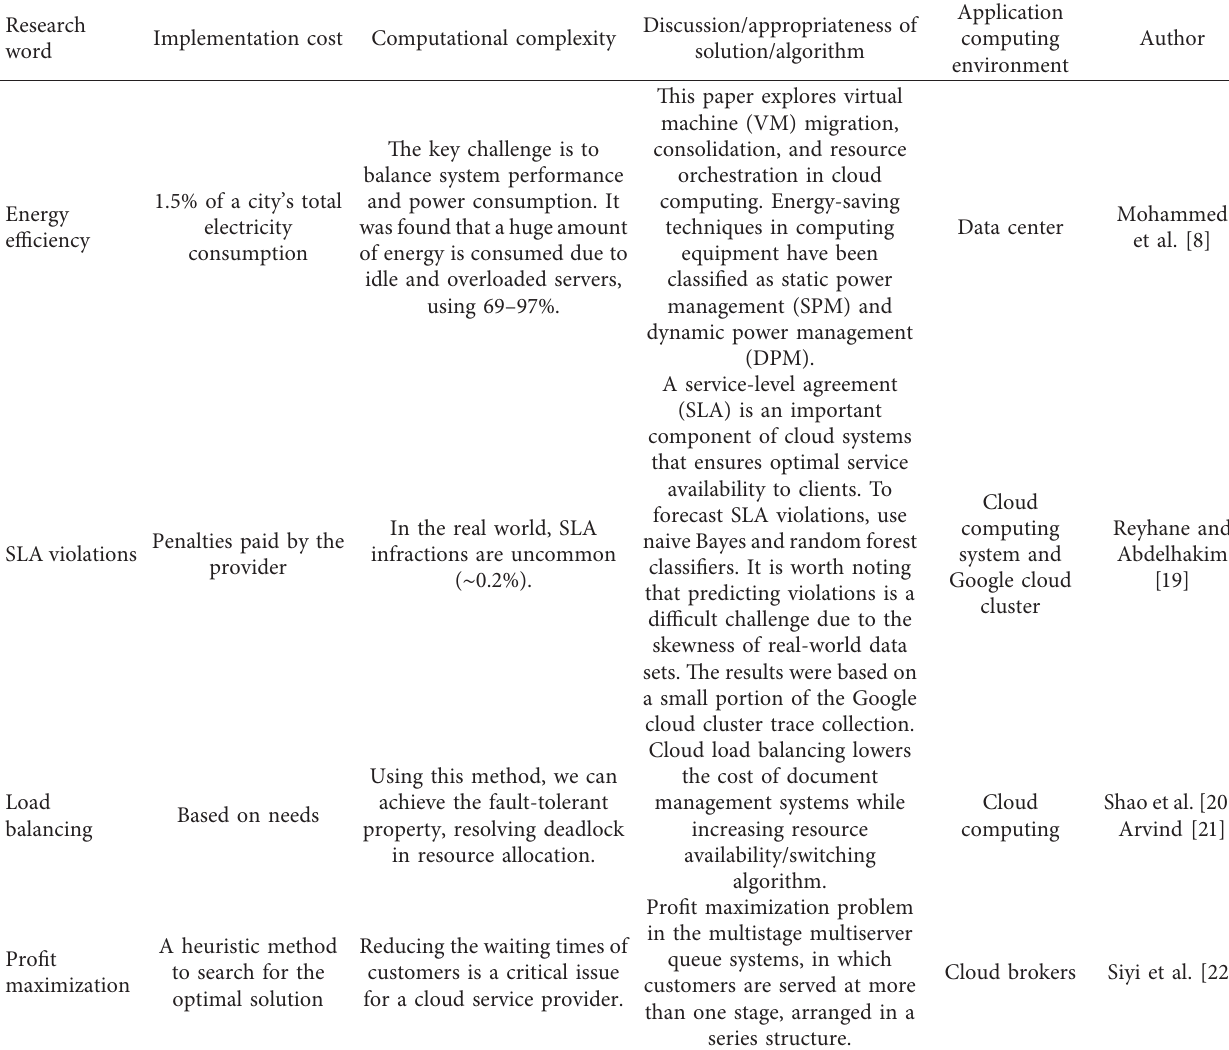
Table 1: Taxonomy of resource